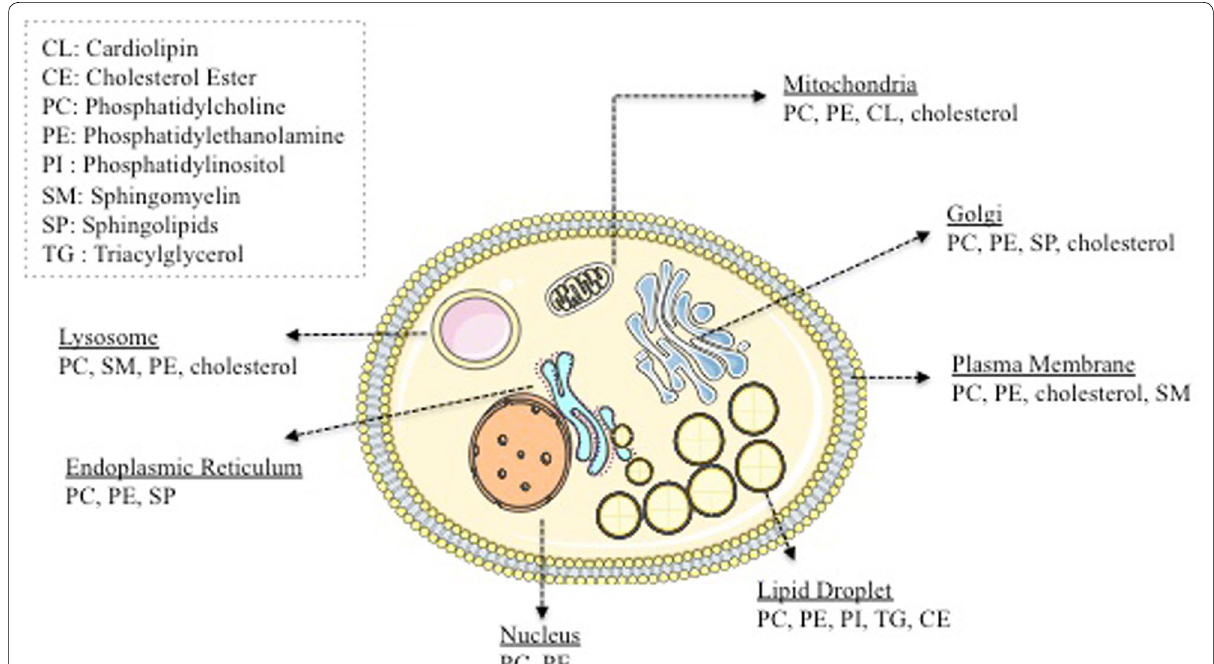
Fig. 2 Lipid distribution of animal cells. In animal cells, lipids are distributed in the plasma membrane (PM) and intracellular organelles. In all membranes, most commonly found lipids are phosphatidylcholines (PC) followed by phosphatidylethanolamines (PE). Cardiolipin is prevalently found in mitochondria. Extra FAs and free cholesterols are esterified in the ER and stored within cytosolic lipid droplet (LD) as triacylglycerol (TG) and cholesterol ester (CE) respectively. Lipid rafts are concentrated with cholesterols and